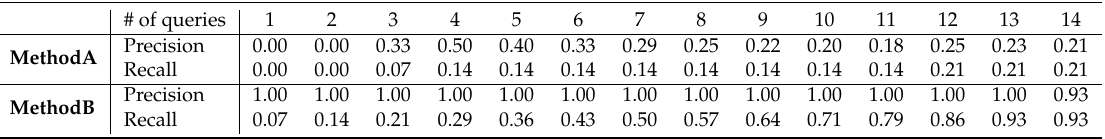
Table 3. Precision-and-recall of our method (Method A) and the related method [12] (Method B). The tested data is Data #3 in Figure 13 is used as tested